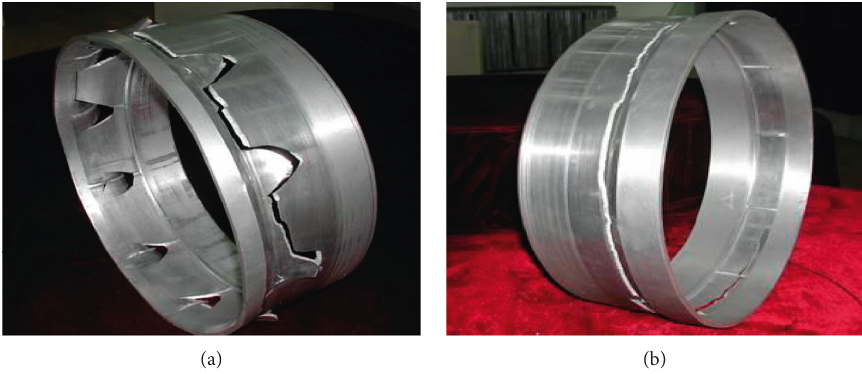
Figure 18: Cracking phenomenon. (a) Small feed ratio spinning sample and (b) large feed ratio spinning sample.